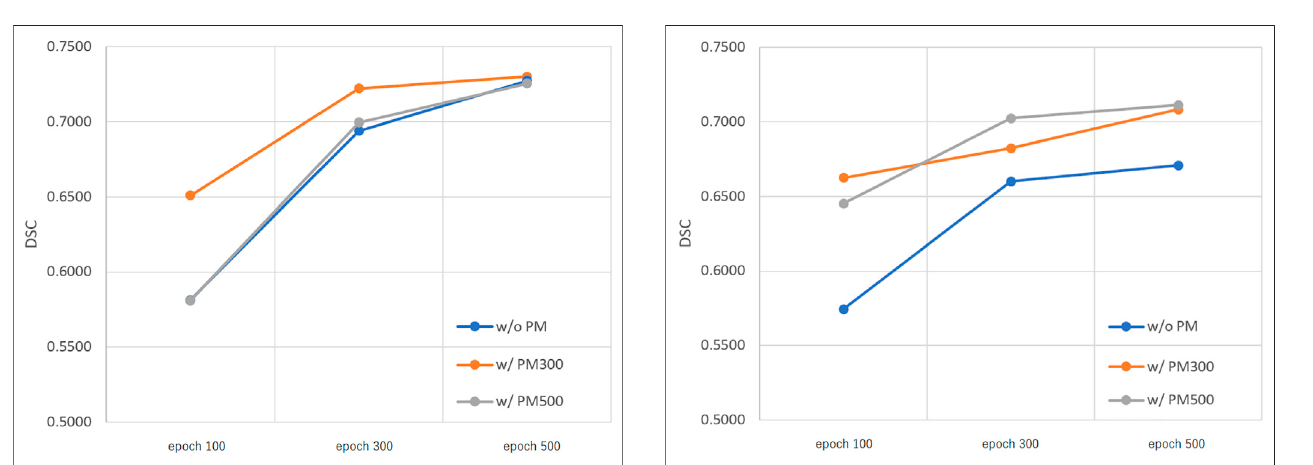
FIGURE 4 | Mean DSC of the test set when using Decathlon mid . Abbreviation: PM, pretrained model; PM 300 , pretrained model obtained from 300epochsoftraining;PM 500 ,pretrainedmodelobtainedfrom500epochsof